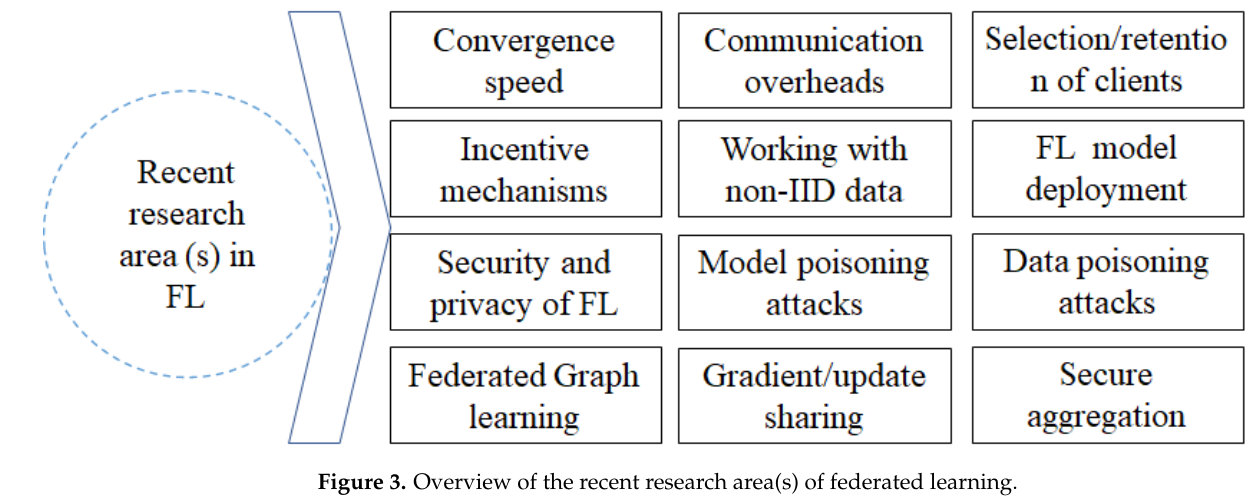
Figure 3. Overview of the recent research area(s) of federated learning.